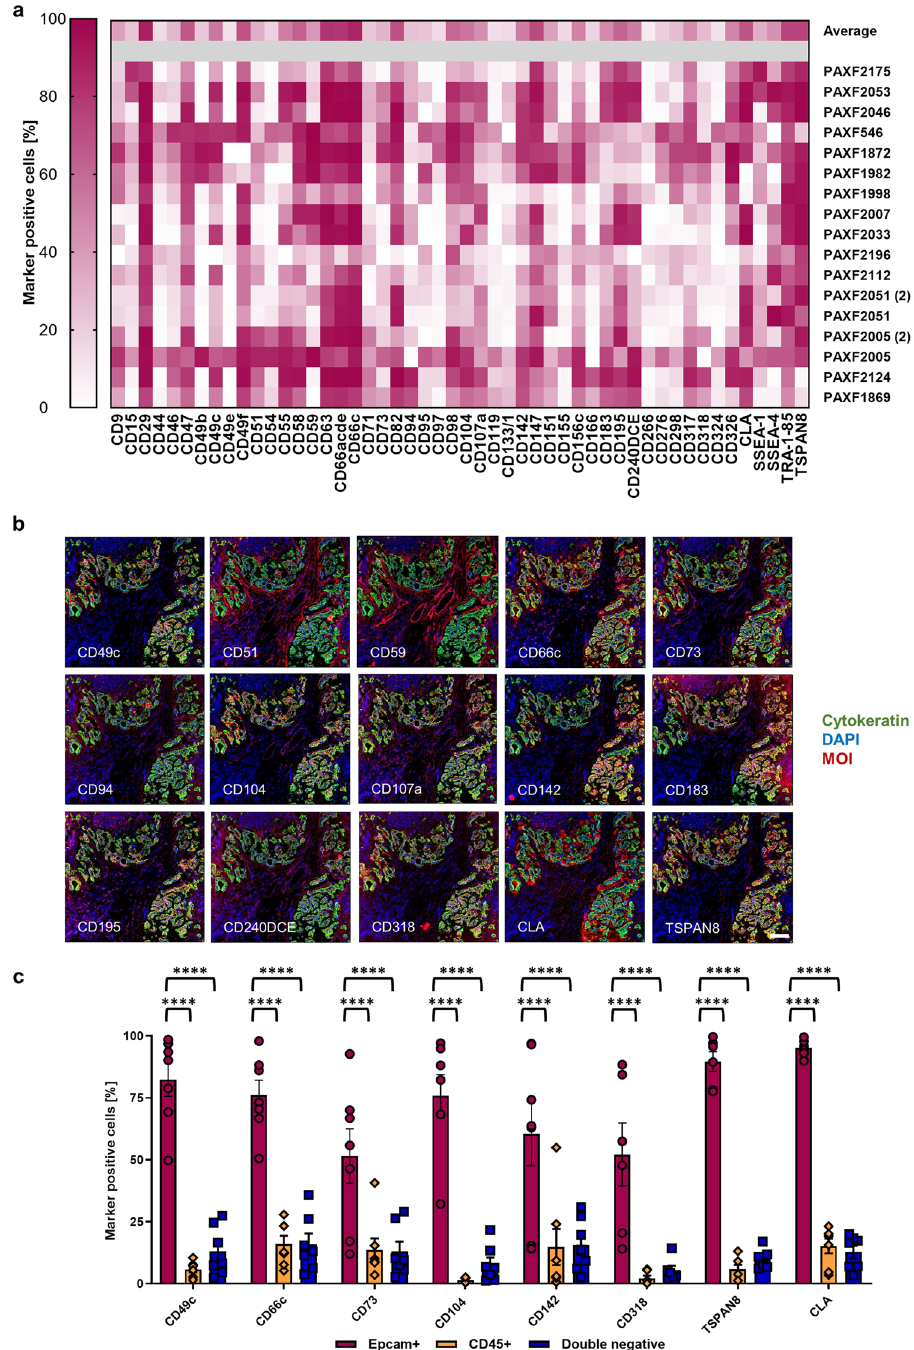
Fig. 1 Identi fi cation of PDAC CAR target candidates. a Top 50 antigens expressed on the cell surface of PDAC PDX models as determined by fl ow cytometry-based screening of a 371 monoclonal antibody panel. b Selection of 15 cyclic immuno fl uorescence images of a representative human PDAC tissue to evaluate co-expression of the marker of interest (MOI) with cytokeratin-positive tumor cells. Images are representative for two cyclic IF runs on two different PDAC specimen. c Flow cytometric analysis of expression for eight target candidates on primary human PDAC samples. Data represent mean ± s.e.m. ( n = 7, **** P < 0.0001 determined through two-way ANOVA with Tukey ’ s test). Scale bar = 100 µ m. Source data are provided as a Source Data fi